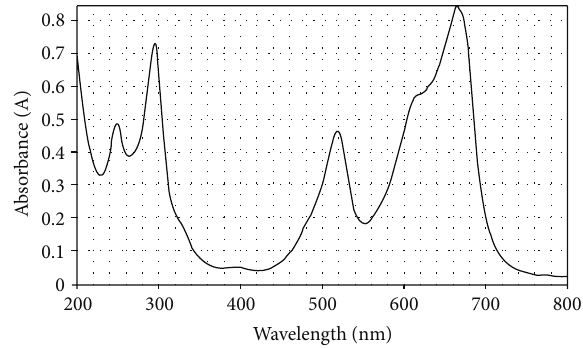
Figure 4: UV spectra of methylene blue. archaeosomes without methylene blue and methylene